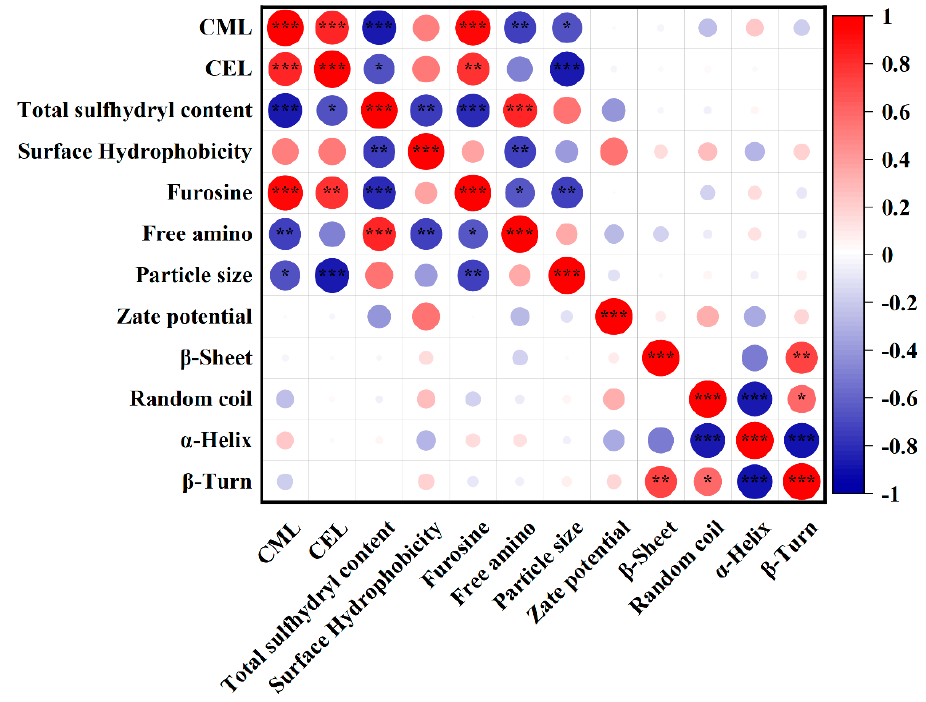
Figure 10. Correlation analysis of all parameters measured in this research of myofibrillar protein and glucose (MPG) under different heating conditions (80 °C and 98 °C, 0 − 45 min). The asterisk (*) denotes significant difference. *: p < 0.05; **: p < 0.01; ***: p < 0.001.